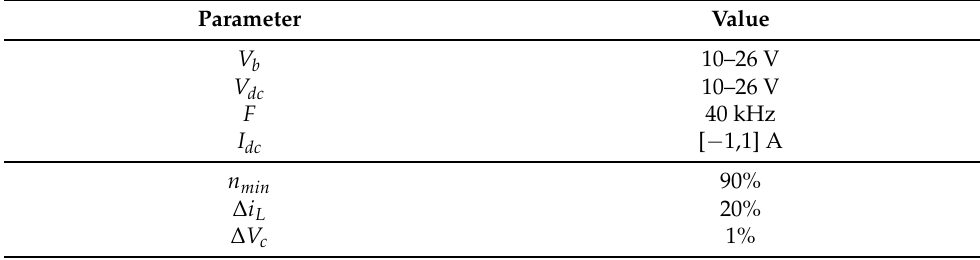
Table 1. Parameters for the design example.